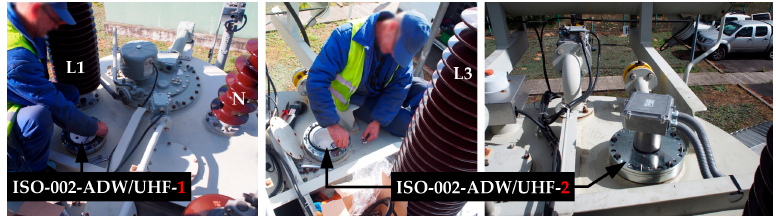
Figure 30. The installation of the active dielectric windows with UHF antennas (ISO-002-ADW/UHF-1 and ISO-002-ADW/UHF-2) in the revision holes of the upper cover of the 31.5 MVA power transformer tank.